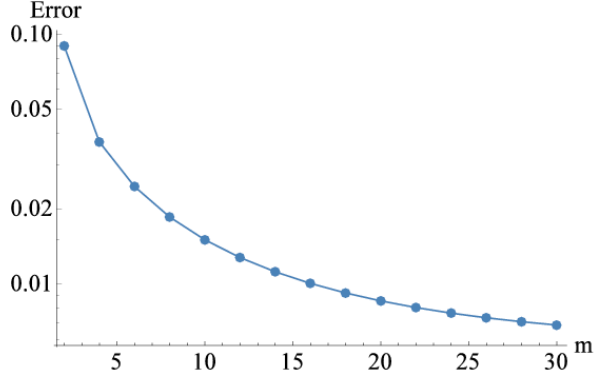
Figure 2. The total square residual error for the SWCNT nanofluid.